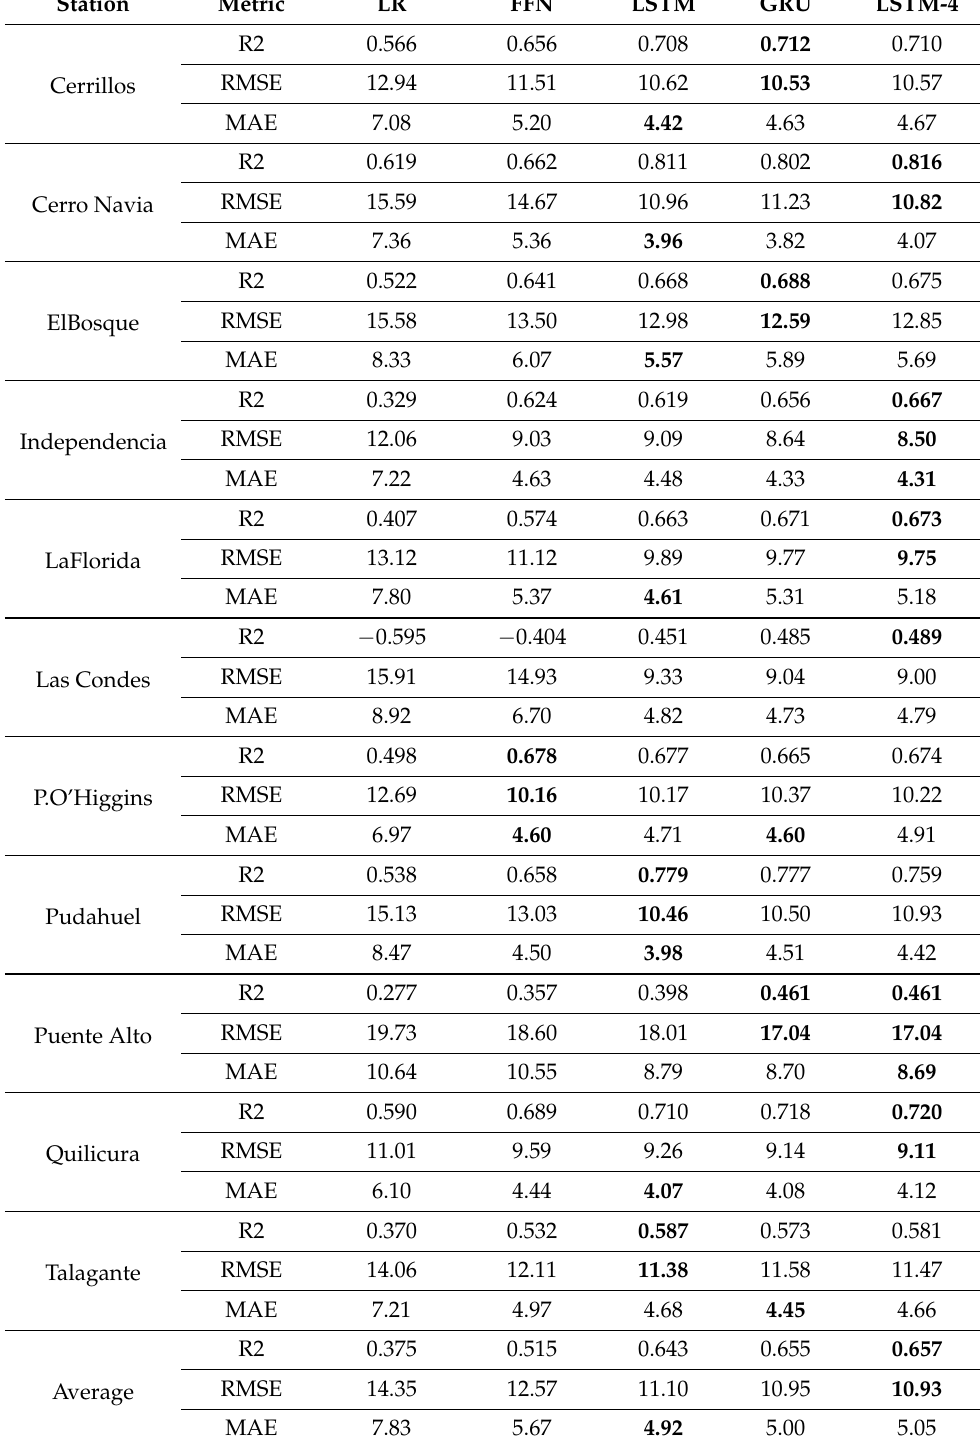
Table 8. Metrics of space-time predictions considering 11 stations, of 1 h in the future. Bold font indicates best